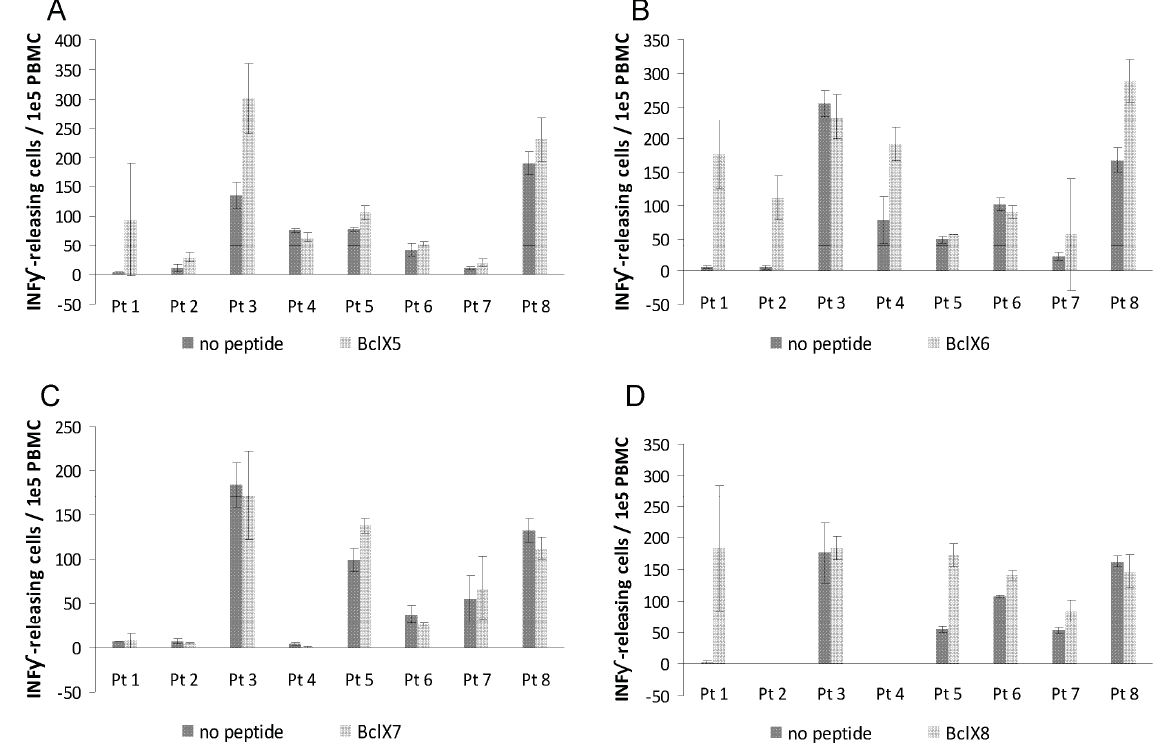
Figure 4. Screening of IFN- (cid:3)(cid:2) producing T-cell responses against BclX(L)-derived peptides as measured by IFN- (cid:3)(cid:2) ELISPOT. PBMC from melanoma patients were analyzed. Eight synthetic long Bcl-X(L)-derived peptides were examined. The average number of Bcl-X(L)-specific spots (after subtraction of background activity) was calculated per 10 5 PBMC for each patient ( black circles